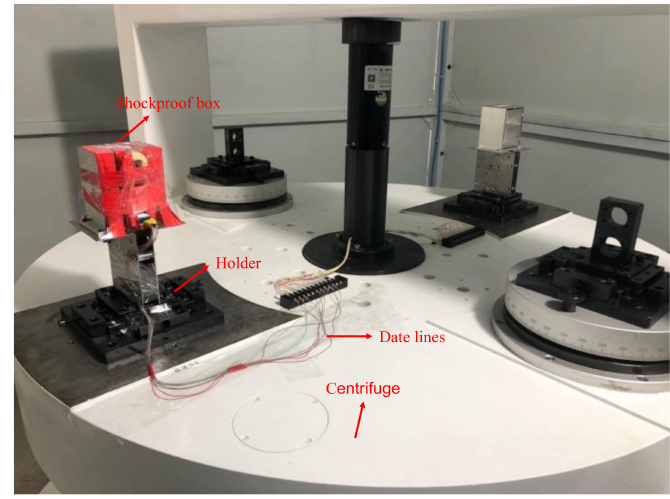
Figure 20. Dynamic test setup on the centrifuge.